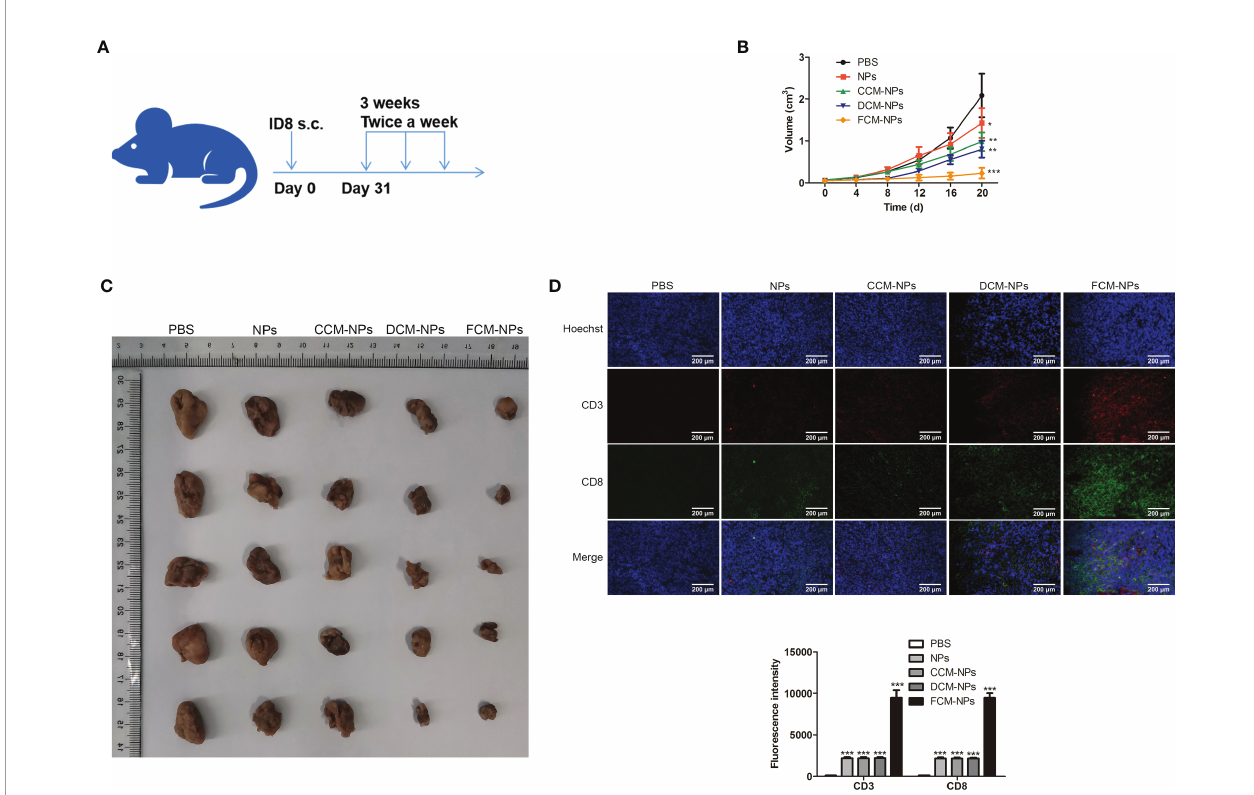
FIGURE 5 | Immune stimulation and therapeutic effect of FCM-NPs on subcutaneous transplanted tumor. (A) Schematic diagram of modeling and treatment of subcutaneous transplanted tumor in mice. (B) Changes in tumor size of mice in PBS, NPs, CCM-NPs, DCM-NPs and FCM-NPs groups. * P < 0.05, ** P < 0.01, *** P < 0.001 vs PBS group. (C) Images of tumors after the mice were sacri fi ced. (D) Immuno fl uorescence staining of CD3 and CD8 in tumor sections. Scale bar = 200 m